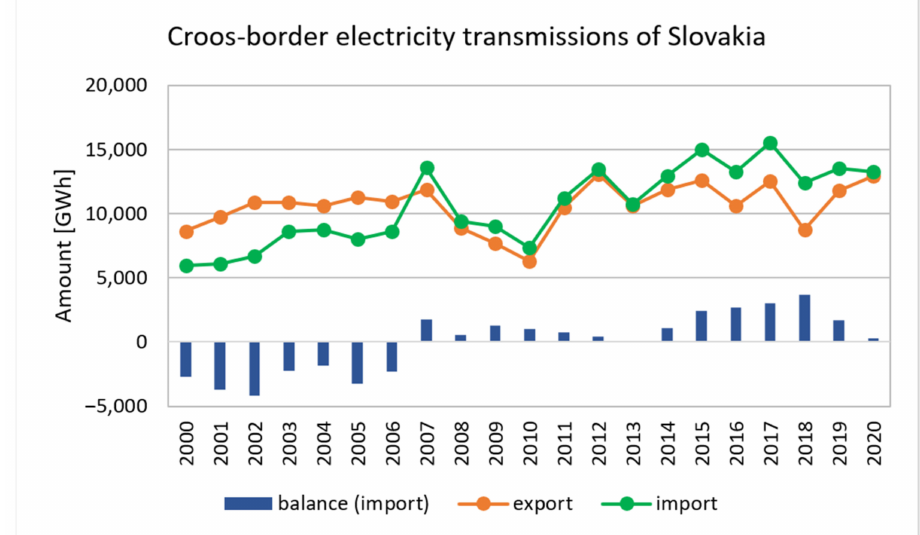
Figure 3. Cross-border electricity transmissions of Slovakia